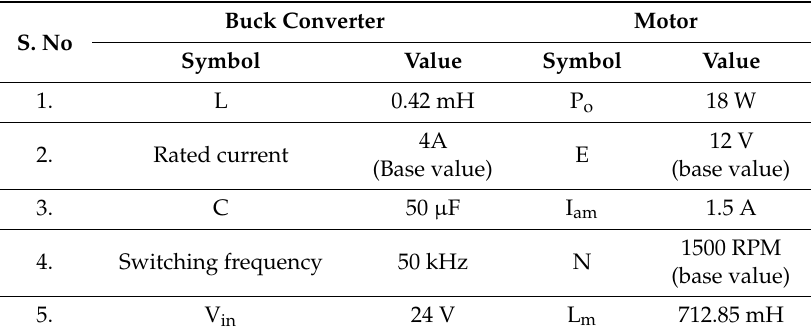
Table 1. Specifications for a buck converter with a dynamic load.